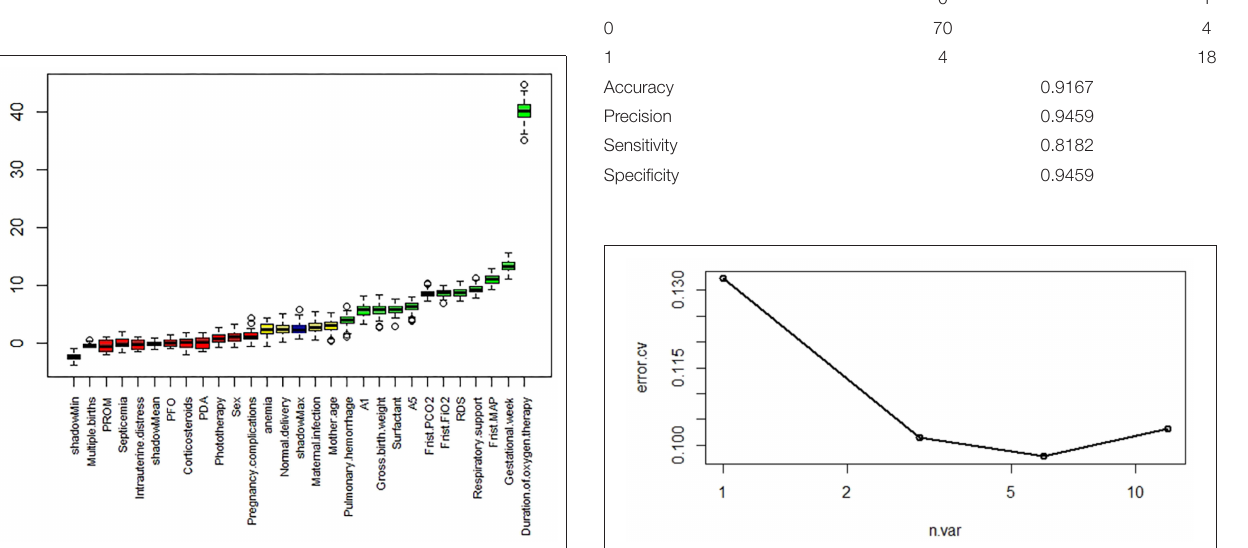
FIGURE 2 | Cross-validation